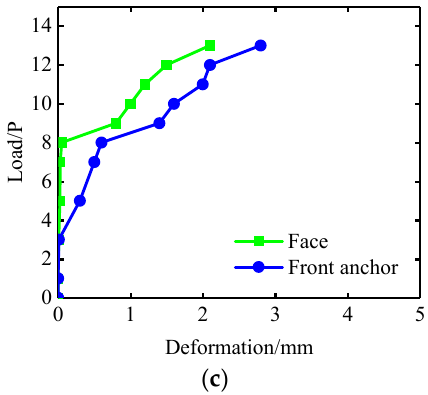
Figure 9. Deformation test results of anchor plug point displacement meter: ( a ) D1; ( b ) D3; ( c ) D2.